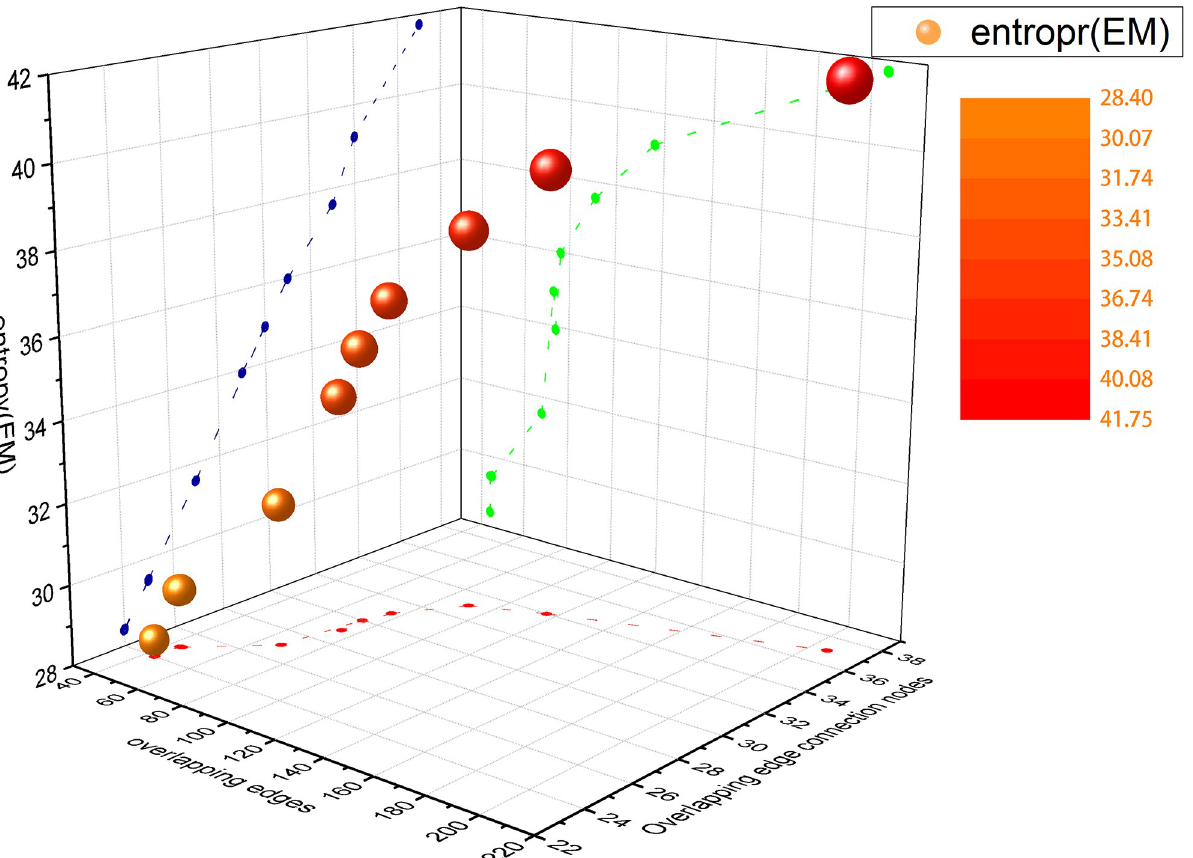
Fig 5. Three-dimensional coordinate scatter plot of tailor shop multiplex network. The green scatter is the trend of the structure entropy about the overlapping edges. The blue scatter is the change in structure entropy with relation to the overlapping edge connected nodes. The red scatter is the correspondence between the overlapping edges and the overlapping edge connected